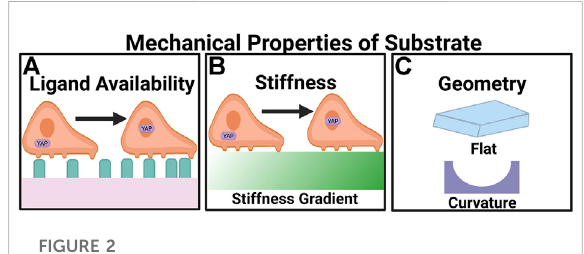
FIGURE 2 Angiogenesisisregulatedbythemechanicalpropertiesofthe microenvironment. (A) Ligand availability regulates the migratory behavior of cells through haptotaxis. In high ligand densities YAP translocates to the nucleus. (B) Greater stiffness upregulates the expression of pro-angiogenic factors. On stiff substrates YAP undergoes nuclear localization. (C) Appropriate curvatures of the substrates can promote